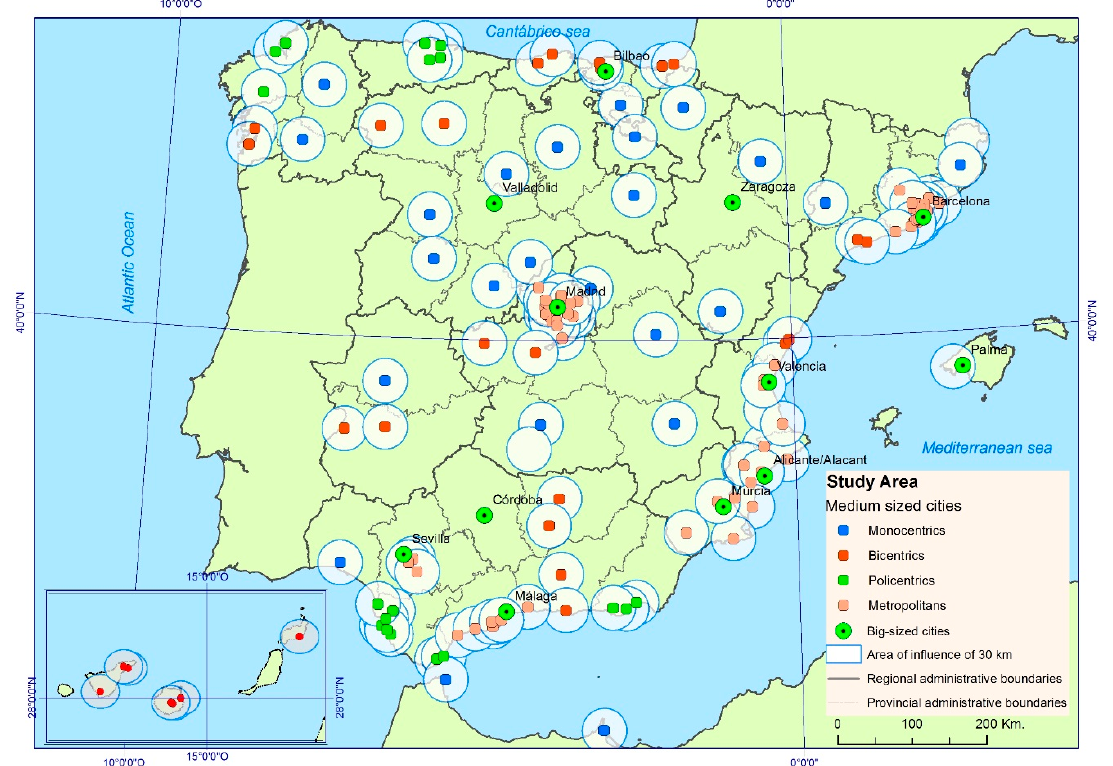
Figure 2. Medium-sized cities typology. Source of information: CNIG [57], INE [55] and own elaboration.